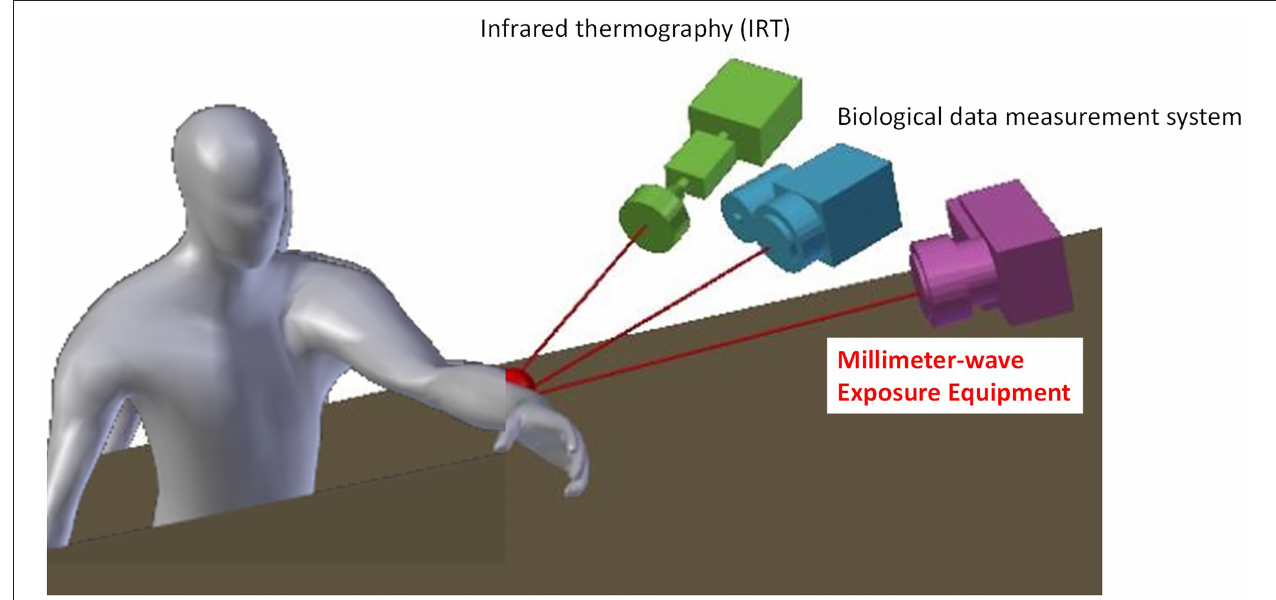
FIGURE 1 | Overview of experimental design to investigate biological effects of 60 GHz MMW exposure on human body.